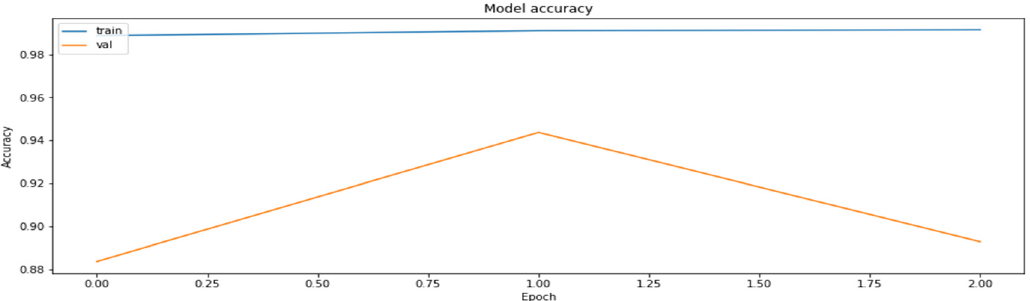
Figure 10. Training and the validation datasets obtained during the application of the weight clustering part of the PCQAT.